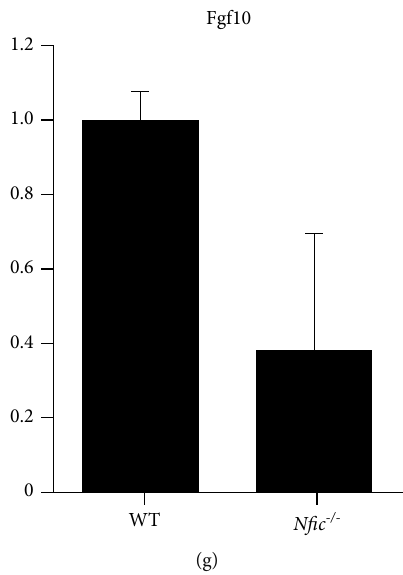
Figure 4: FGF8 is the upstream signaling molecule for N fi c -Sox2 in dental epithelial cells, and N fi c induces FGF10 in the dental mesenchymal stem cells to modulate the proliferation of DESC through epithelial-mesenchymal interactions. (a) Sox2 protein and (b) mRNA expression levels were analyzed when treated with FGF8 and Shh in the control and N fi c -silenced dental epithelial cells. (c) Schematic representation of Sox2 promoters and (d) the deletion of the N fi c binding motif. The e ff ect of FGF8 on the Sox2 promoter activity in the absence of the N fi c binding motif is shown. n = 5 , ∗ p < : 05 . (e) Fgf10 mRNA and (f) protein expression levels were examined when N fi c was overexpressed or silenced. (g) FGF10 expression levels were analyzed in the primary cultured dental pulp cells from N fi c KO mice. n = 5 , ∗ p < : 05 . (h) Schematic diagram of hypothesized intercellular interactions involved in stem cell homeostasis in dental epithelial cells. Data are presented as the mean ± SD . Abbreviations: FGF: fi broblast growth factor; LUC: luciferase; Over: overexpression; Shh: sonic hedgehog; WT: wild